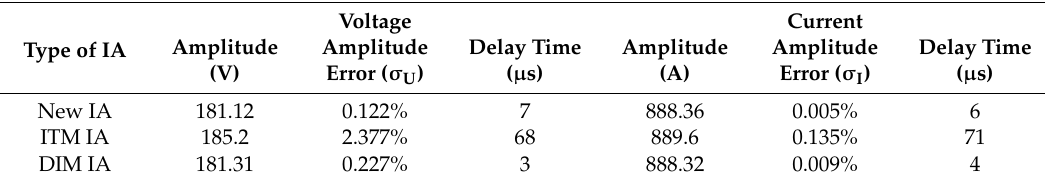
Table 4. Data analysis results of the DSS